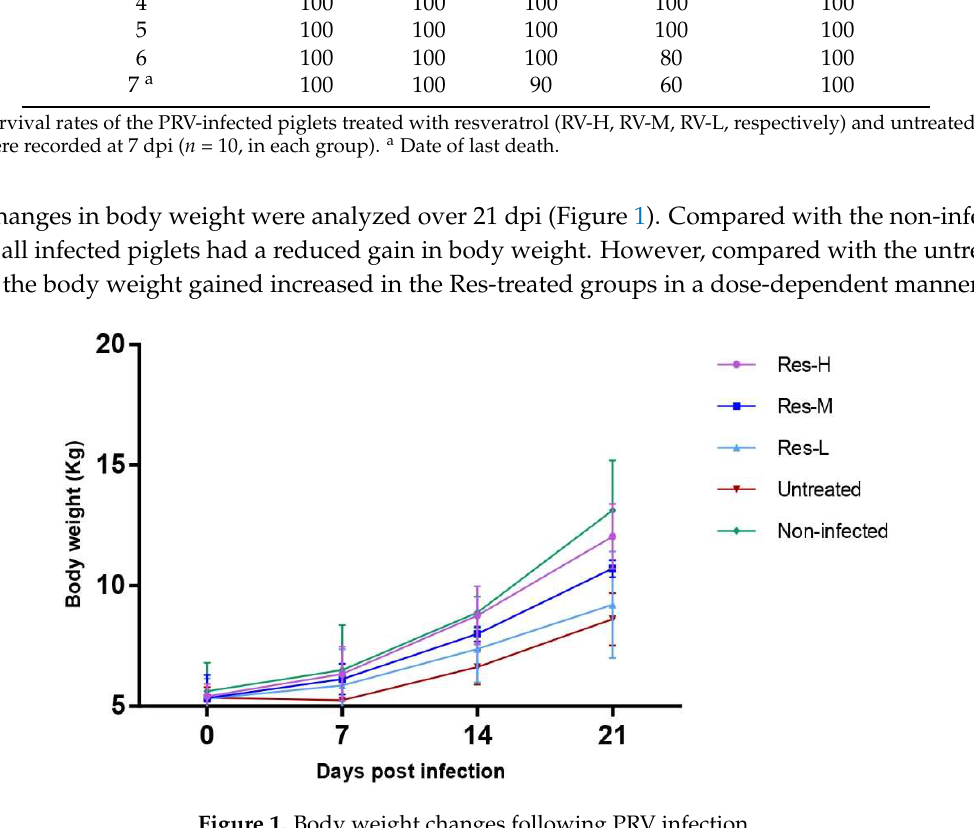
Figure 1. Body weight changes following PRV infection.